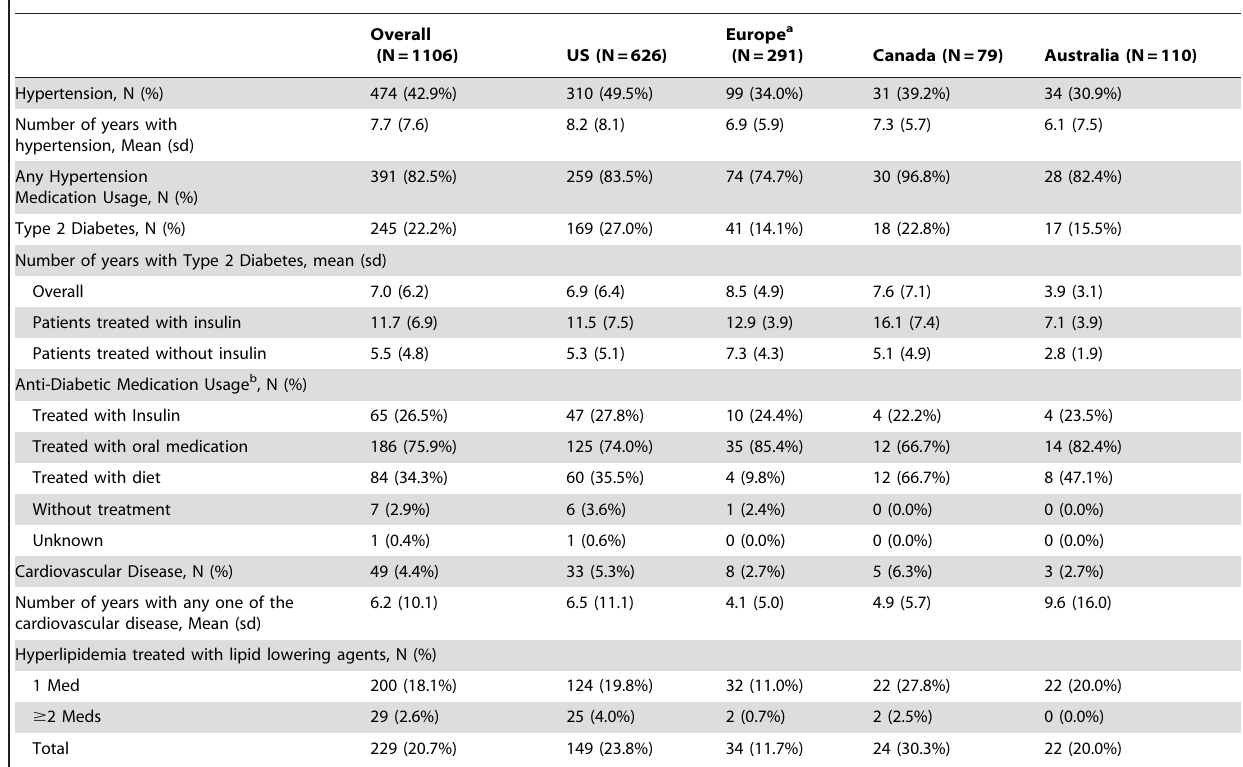
Table 3. Baseline Comorbid Conditions by